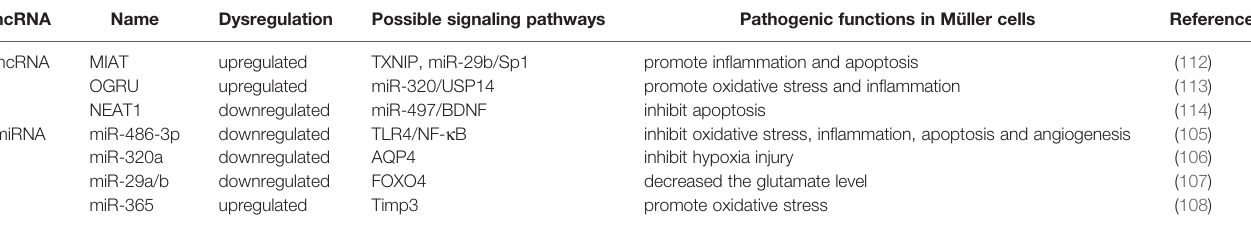
TABLE 3 | The role of miRNA ln and lncRNA in DR and their mechanisms through müller cell and targets.